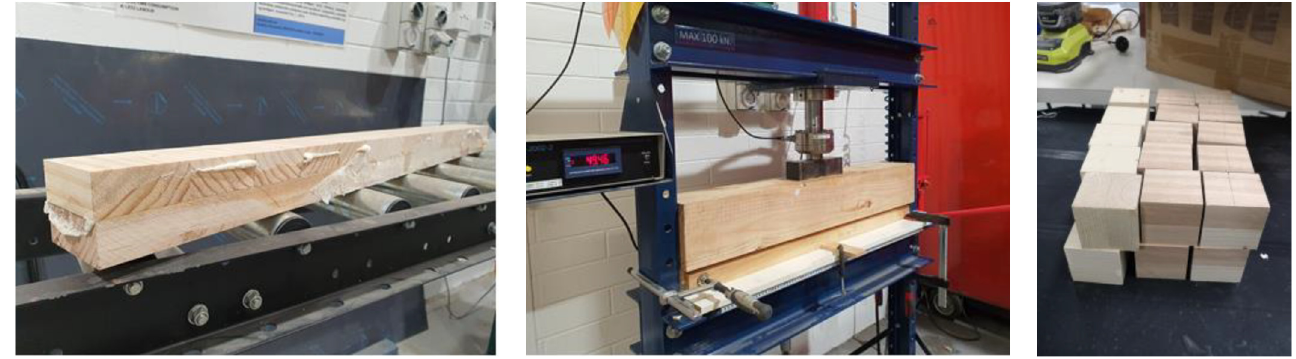
Figure 2. Lamellae preparation, clamping process and final specimens for testing.